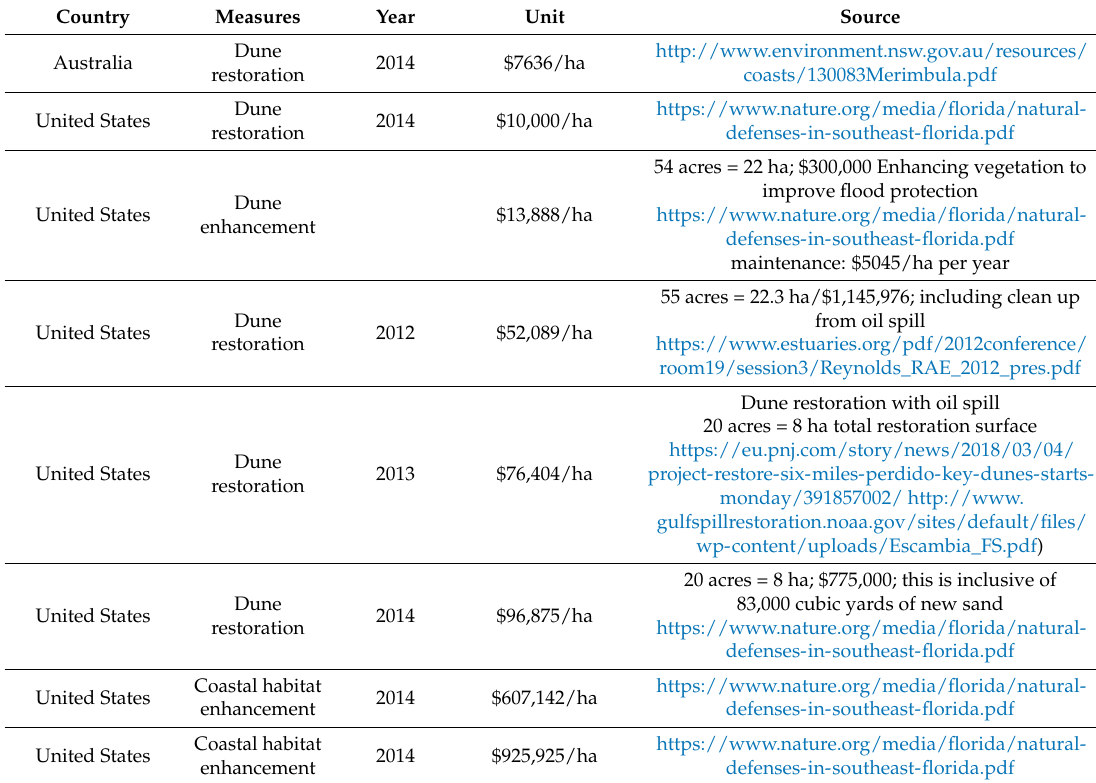
Table A4. Cost nature-based solution,